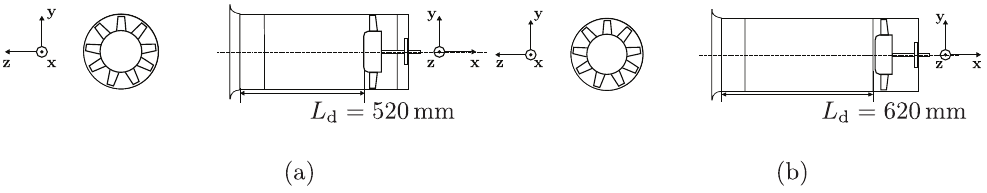
Figure 8. Schematic representation of the reference (R) duct design. F indicates that the in fl ow was undisturbed and S and L stand for the short L d = 520 mm and long version L d = 620 mm. (a) Reference short duct fan setup, RFS. (b) Reference long duct fan setup, RFL.